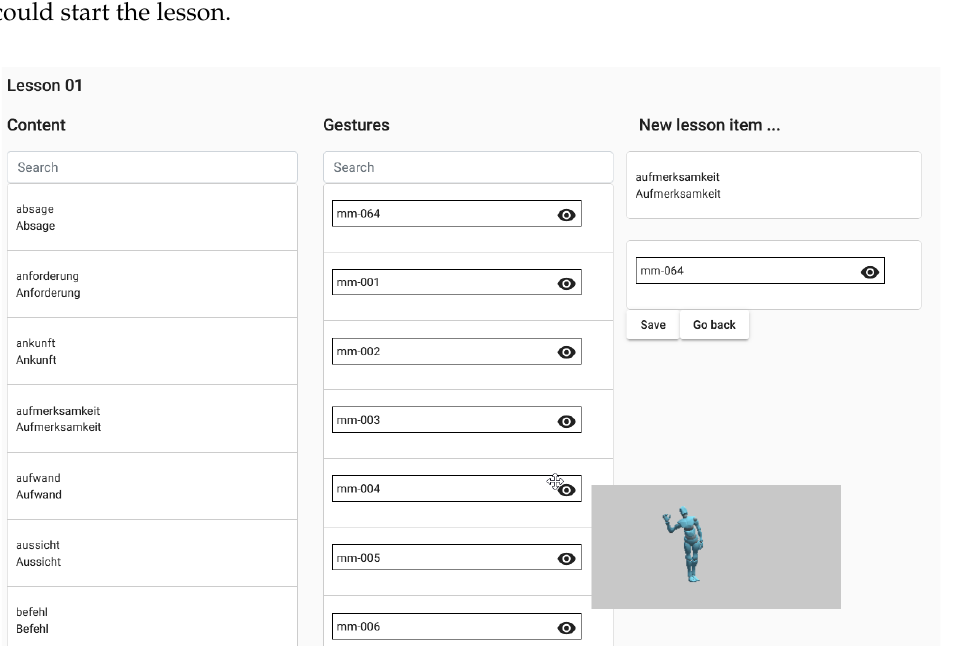
Figure 5. Screenshot of the reference implementation’s lesson player. A robot-like avatar enacted the gesture, while the learning content was displayed in text and spoken out loud by the text-to-speech engine.